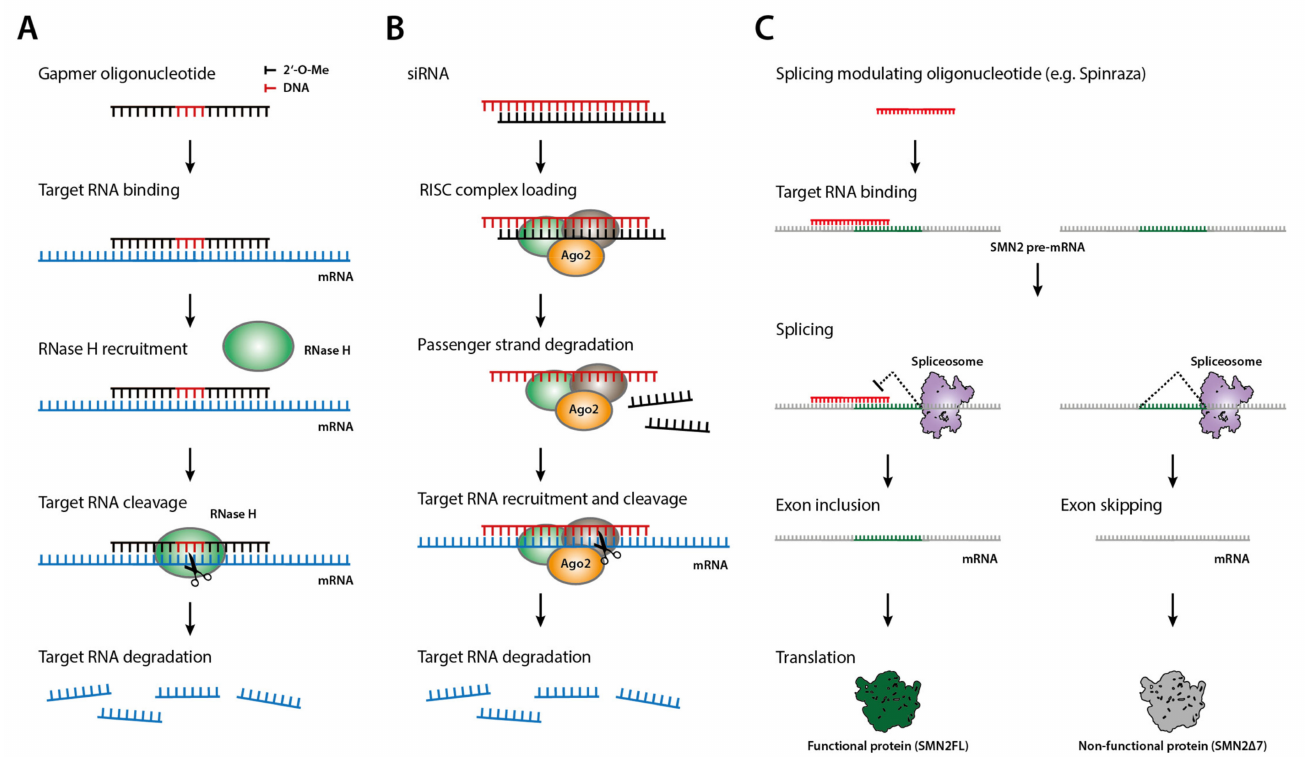
Figure 3. ( A ) Gapmer oligonucleotides contain a short DNA sequence embedded in a 2 (cid:48) -OMe-modified context. The gapmer binds its target mRNA, and this complex then recruits RNase H. The cleavage position of RNase H in the target mRNA is directed by the position of the DNA building blocks, and the cleaved mRNA is degraded. ( B ) Short interfering RNA (siRNA) contains two short RNAs with terminal overhangs, which recruit the RISC complex. This complex cleaves the non- targeting passenger strand RNA and then binds its target mRNA sequence-specifically. The target mRNA is then cleaved by the Argonaute protein and further degraded. ( C ) Splicing-modulating oligonucleotides bind their target RNA, often in proximity to an intron-exon junction, which results in the omission of this junction by the spliceosome during splicing. This can be used to correct pathogenicities caused by splicing defects, such as muscular dystrophy.